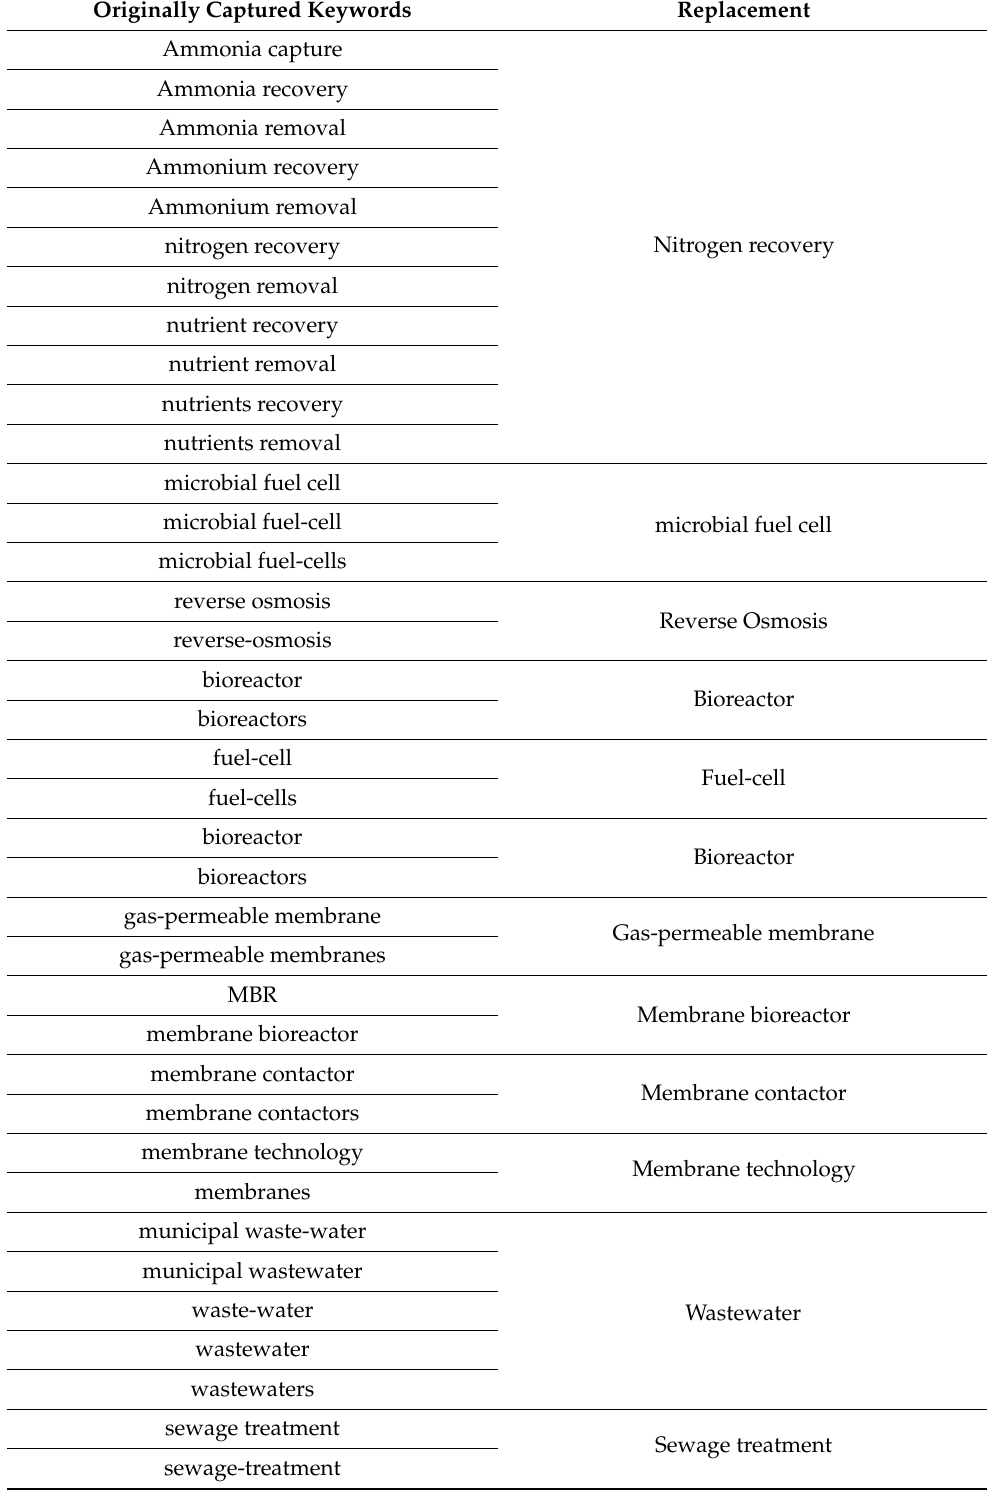
Table 1. Thesaurus components for keywords occurrence